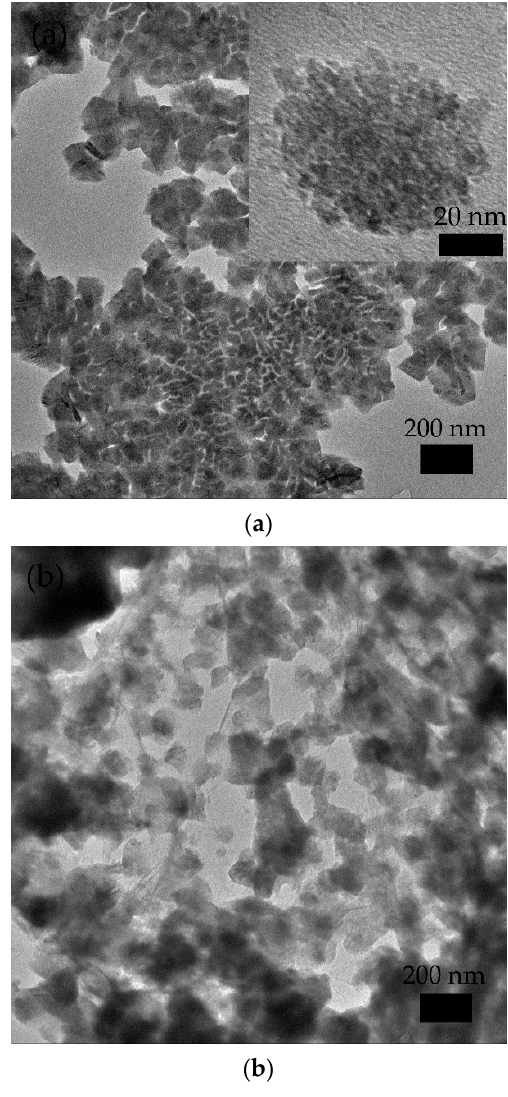
Figure 4. TEM images of ( a ) γ MnS and ( b ) graphene- γ MnS.